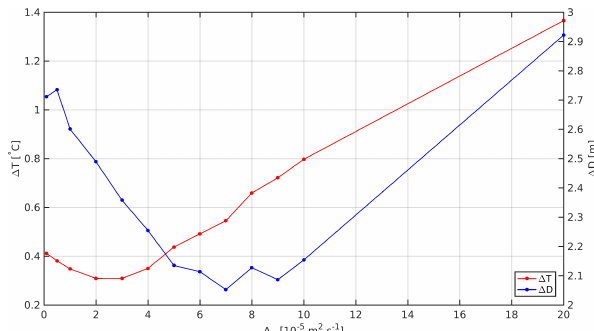
Figure 19. Series E: (cid:49)T and (cid:49)D for ROMS runs E1–E13. Both quantities were computed only for the period after 15 June at